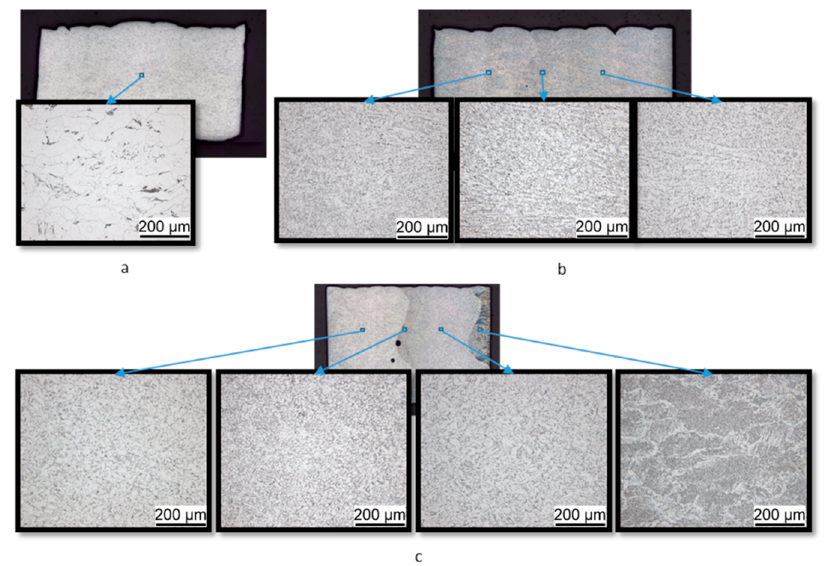
Figure 9. Micrographs of the specimen manufactured with ( a ) conventional GMAW, ( b ) CMT standard, and ( c ) CMT cycle step.